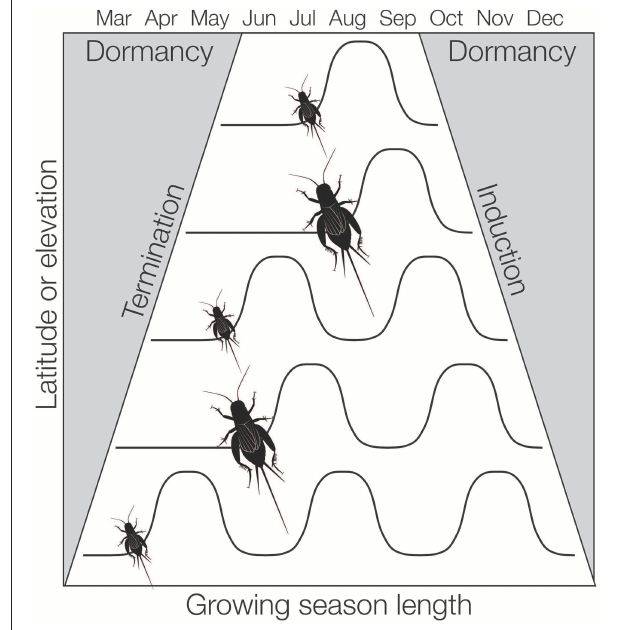
FIGURE 1 | How season length can affect the number of generations per year (voltinism) and body size in insects. As latitude or elevation increases, changes in the termination and initiation of diapause can shift to accommodate decreasing season length. Likewise, insects may develop faster and/or reach smaller adult body sizes to accommodate shorter growing seasons. Body size can also decrease in the south as species accommodate more generations per year. This figure is modified from Levy et al.